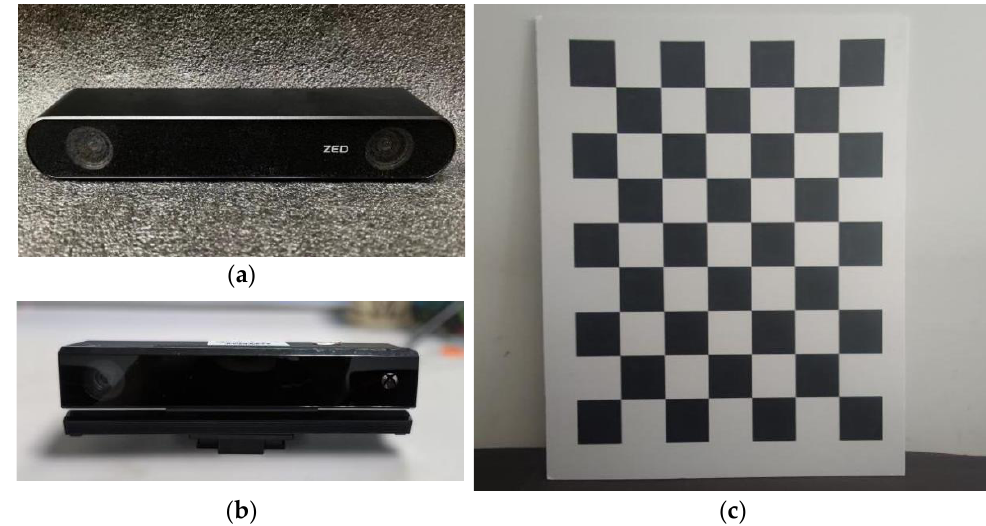
Figure 9. Equipment used in the experiment: ( a ) ZED 2i camera; ( b ) Kinect v2.0 camera; ( c ) flat calibration board.